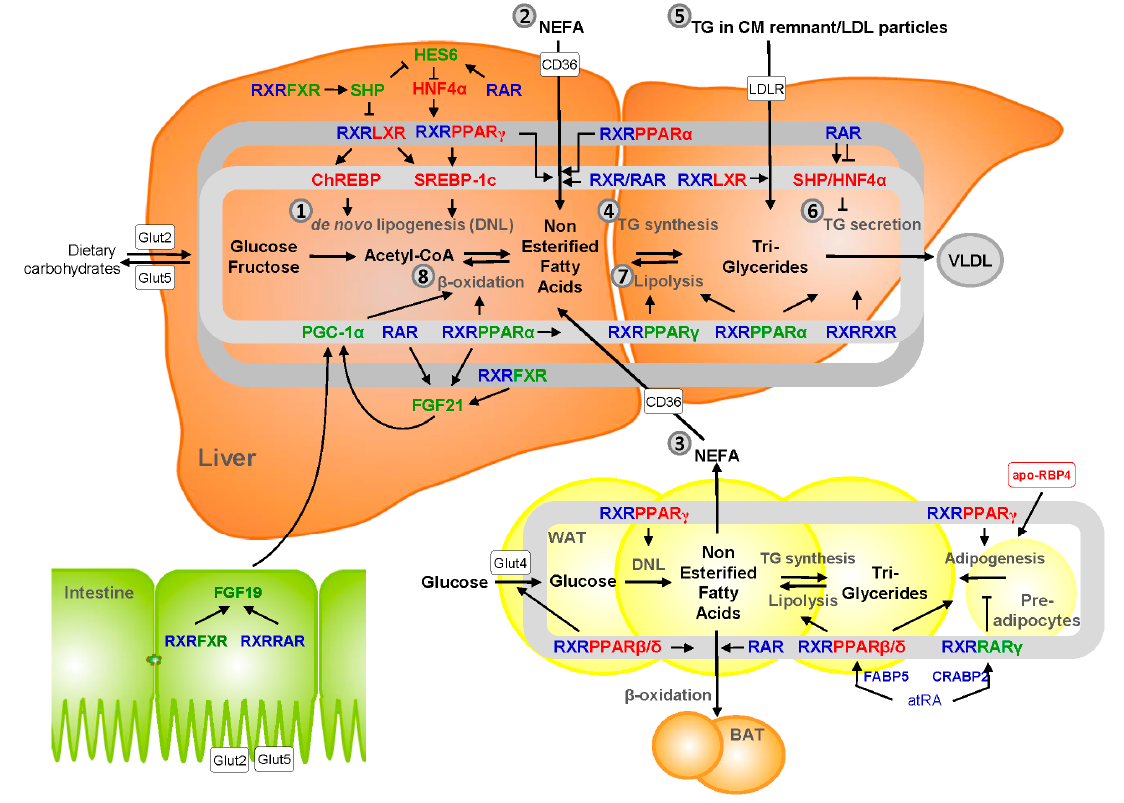
Figure 2. Regulation of hepatic lipid metabolism by vitamin A metabolites. Triglyceride synthesis and breakdown is subdivided into eight steps: (1) de novo lipogenesis (DNL) in the liver, (2) influx of dietary lipids (delivered as non-esterified free fatty acids (NEFAs) or as triglycerides (TG) in chylomicrons), (3) influx of NEFAs produced by adipose tissue (primarily from white adipose tissue (WAT)), (4) esterification of lipids (mainly to TG) and packaging into lipid droplets, (5) influx of TG carried in CM remnants and low density lipoproteins (LDL), (6) efflux of TG carried in very low density lipoprotein (VLDL)-particles, (7) TG hydrolysis producing NEFAs, and (8) catabolism of NEFAs through mitochondrial and peroxisomal β -oxidation. Direct transcriptional regulation of lipogenic/lipolytic genes is shown in the inner (light gray) ring. Indirect transcriptional regulation is shown inside or outside the outer (dark gray) ring. Vitamin A-related factors are indicated in blue. Factors that promote lipogenesis are shown in red; factors promoting lipolysis in green. Relevant regulation and factors in adipose tissue and the intestine are also included (see main text for details about the specific genes that are regulated in each step). Additional abbreviations: FXR—Farnesoid X Receptor, SHP—Small